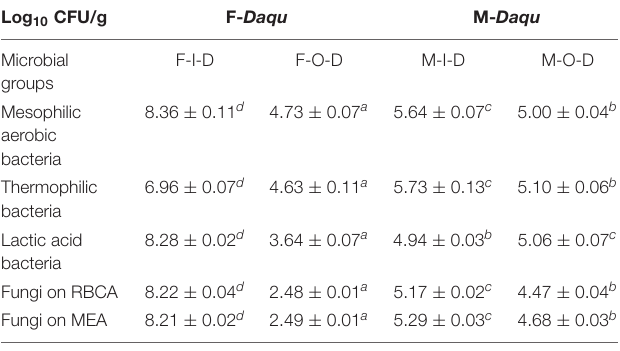
TABLE 2 | Microbial counts in Daqu